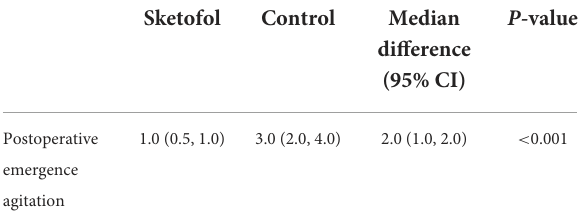
TABLE 3 Primary outcome: postoperative emergence agitation evaluated 5min after awakening. Sketofol Control Median difference (95%